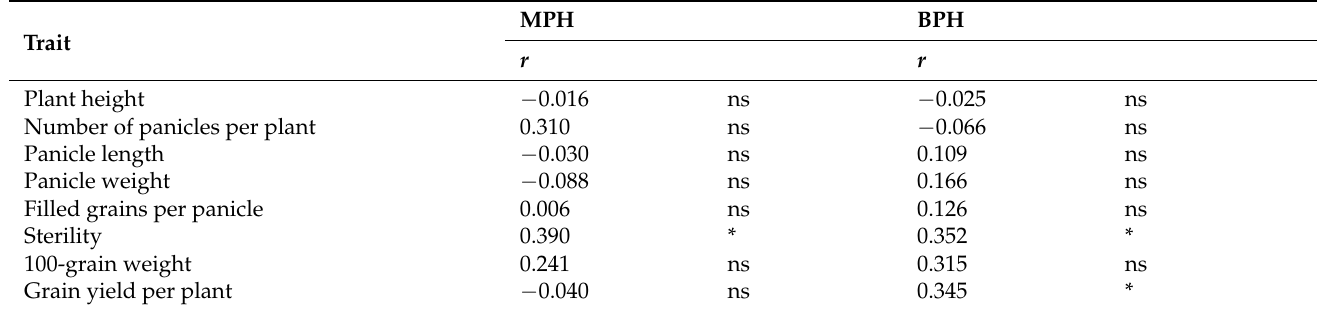
Table 4. Correlation coefficients between microsatellite genetic similarity and mid-parent (MPH) and better parent (BPH) heterosis values for agronomic traits, yields and its components traits in diallel cross among eight rice genotypes under drought